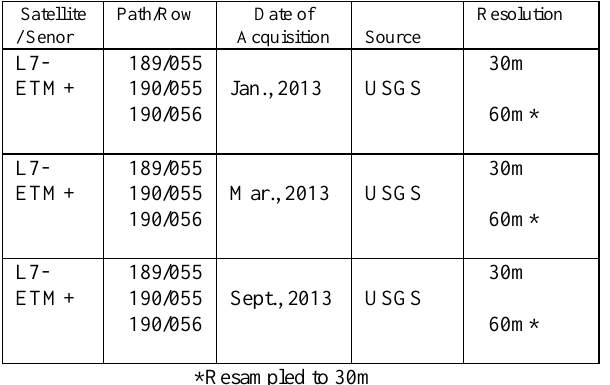
Table 1: Satellite Datasets